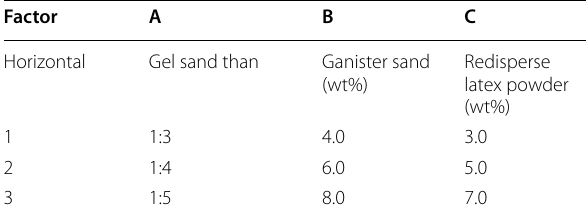
Table 6 Level table of admixture factors